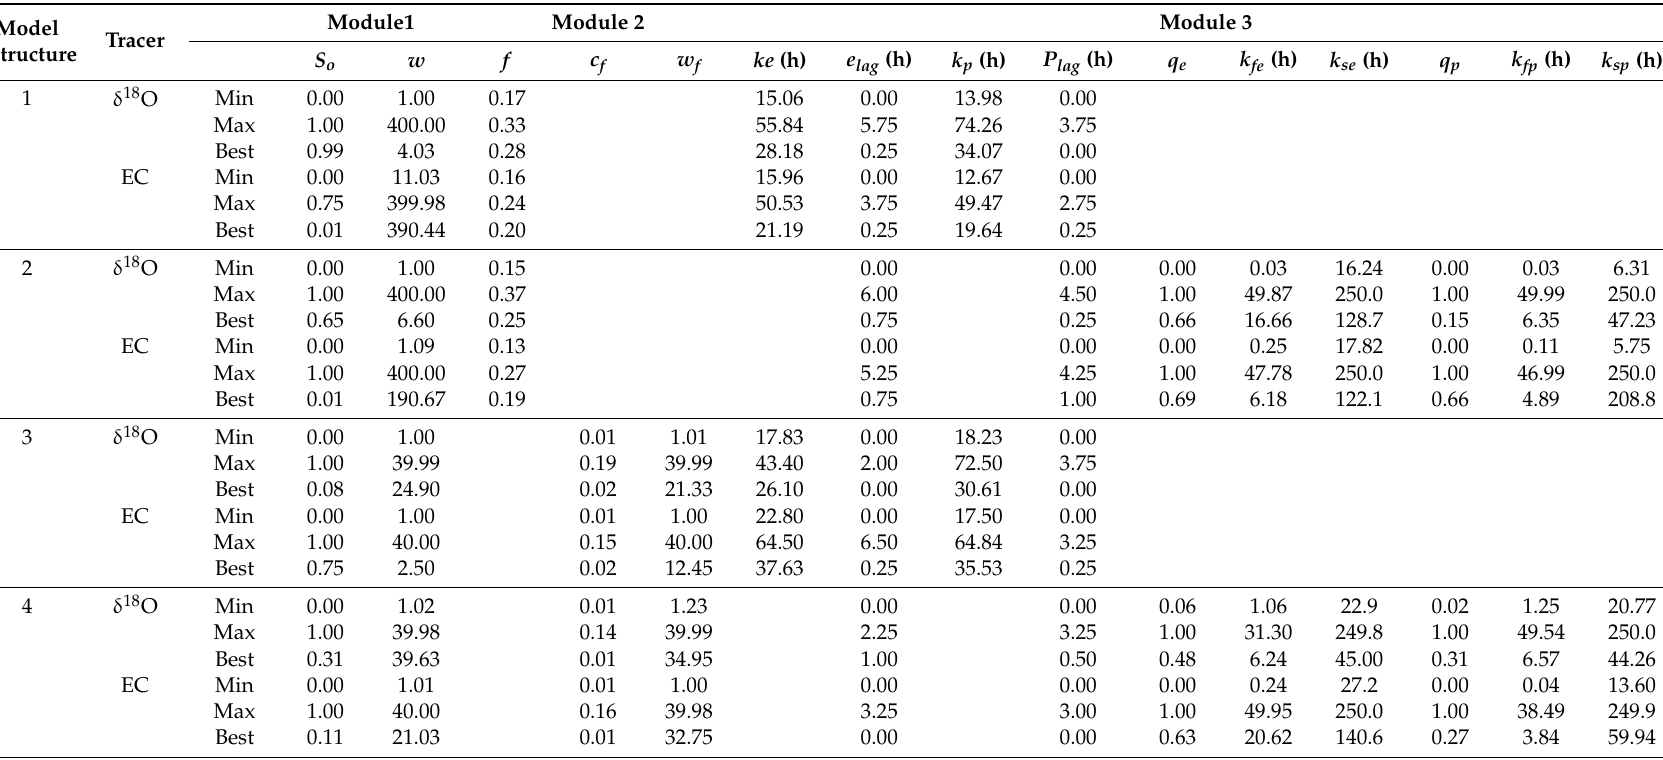
Table 2. Parameter sets that yielded the highest NSEs values for each TraSPAN model structure and tracer used for calibration. Model